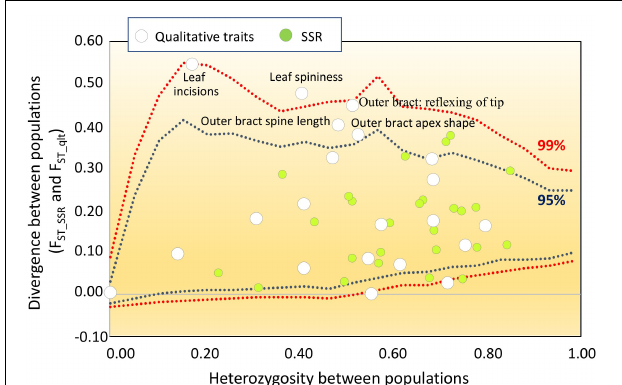
FIGURE 6 | F ST outlier analysis for qualitative traits. White dots, qualitative traits; green dots, SSR loci. The qualitative traits were treated as multiallelic loci. The divergence between populations was calculated for both qualitative trait (F ST_qlt ) and SSR (F ST_SSR ) conditioned to the heterozygosity between populations. The data obtained for the qualitative traits were then overlapped with the neutral envelope obtained by simulation using 26 SSRs. Blue and red dotted lines, 95% and 99% limits of the neutral envelope,